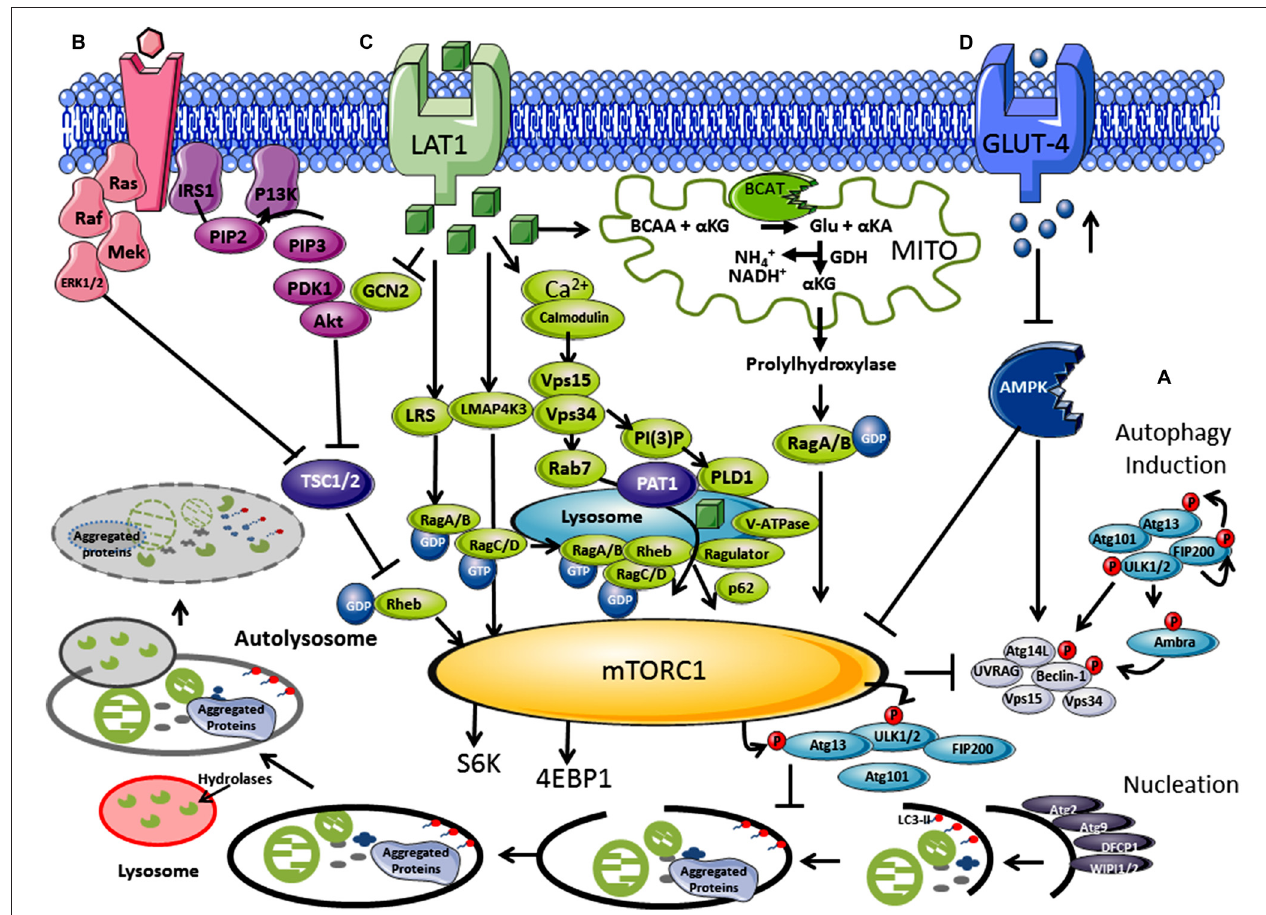
FIGURE 1 | Regulation of autophagy by nutrients and hormones via the mammalian target of rapamycin (mTOR) signaling pathway. (A) Autophagosome induction begins with the activation of the ULK1/2 protein kinase complex that includes the autophagy related proteins (Atgs, where Atg13 is indispensable) and the 200 kDa focal adhesion kinase family-interacting protein (FIP200). This is followed by a nucleation step that is dependent on the class III phosphatidylinositol 3-kinase or human vacuolar protein sorting 34 (hVps34), complexed with BCL-2 interacting moesin-like coiled-coil protein 1 (Beclin 1) and Vps15. Phosphorylation of phosphatidylinositol (PtdIns) by hVps34 signals the recruitment of other autophagy proteins required for elongation . Beclin 1 is involved in two recruitment complexes, the Atg14L and UV radiation resistance-associated gene (UVRAG) complex, which are required for phagophore formation and phagocytosis, respectively. Elongation and closure of the autophagosome requires several Atg proteins, hVps34 and microtubule-associated light chain 3 phosphatidylethanolamine (LC3), which is regulated by GTPase Rab5. The outer membrane of the autophagosome then fuses with a lysosome, exposing the inner single membrane to lysosomal hydrolases whereby the contents are degraded. (B) Hormones and growth factors such as insulin and insulin-like growth factor (IGF-1) trigger mTORC1 activity through a cascade of events resulting in recruitment and activation of Akt which induces phosphorylation and degradation of tuberous sclerosis complex protein 2 (TSC2). TSC2 degradation permits GTP-bound Rheb to directly interact and activate mTORC1. The Ras-ERK pathway also activates mTORC1 through inhibitions of TSC1 and TSC2. (C) Amino acids, in particular leucine, regulate the mTORC1 through the Rag complex